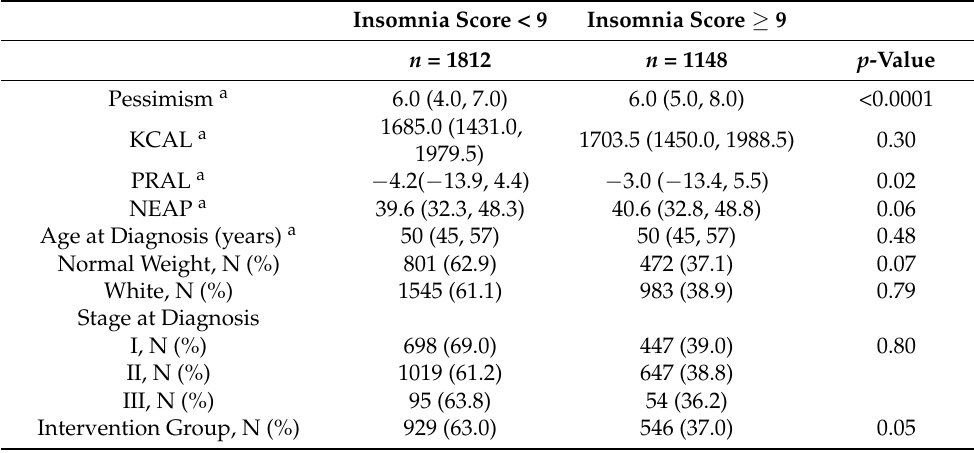
Table 1. Baseline characteristics of breast cancer survivors by insomnia scores (N =